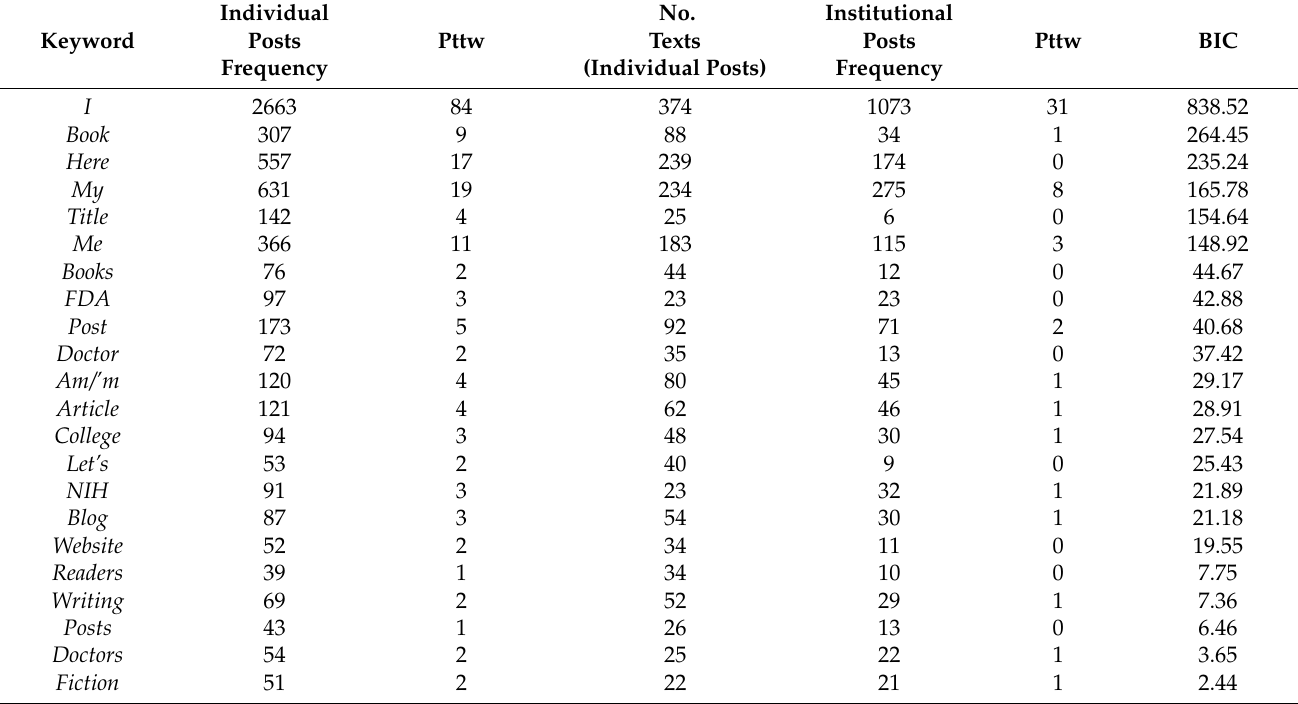
Table 2. Participant-related keywords: individual vs. institutional blog